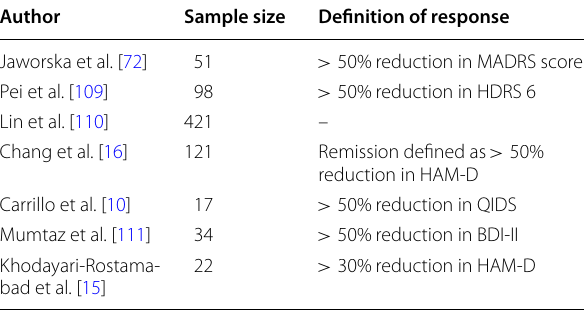
Table 6 Pharmacological treatment response sample